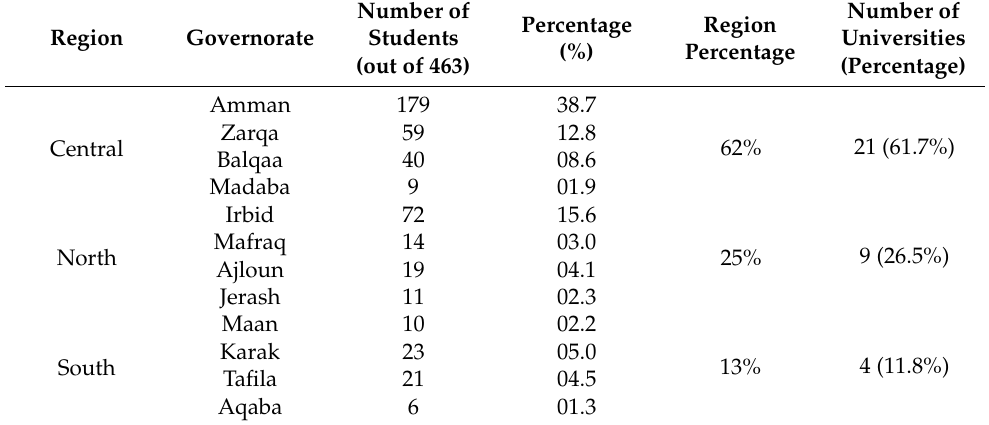
Table 2. Students and university